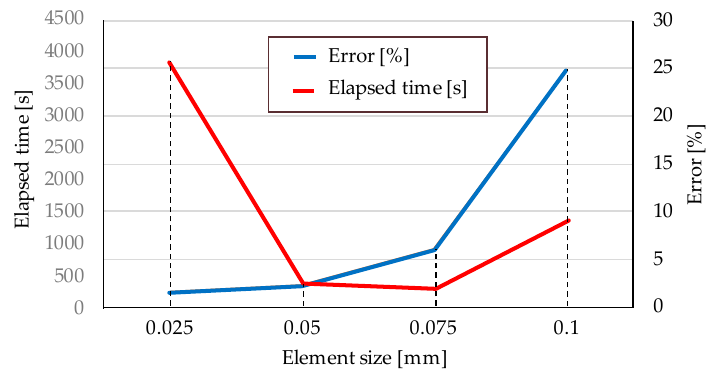
Figure 6. Variation of the elapsed time required for running the simulation and the obtained error compared with the experimentally measured depth of the weld bead as the element size varies for the case of the Test 4.